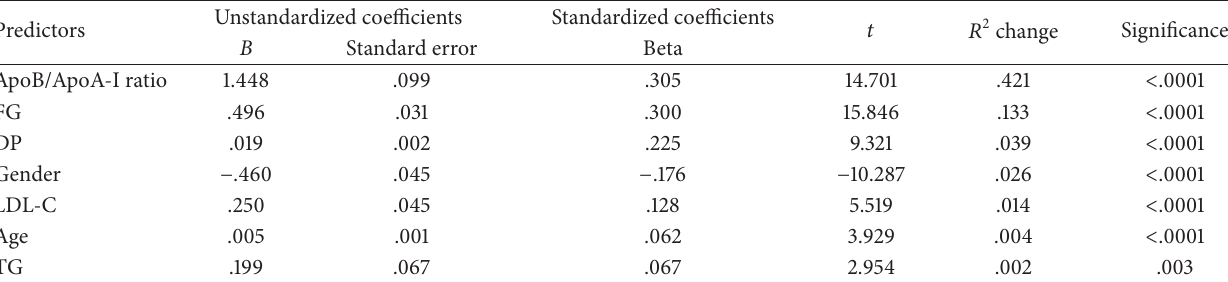
Table 6: Multiple regression models predicting insulin resistance.